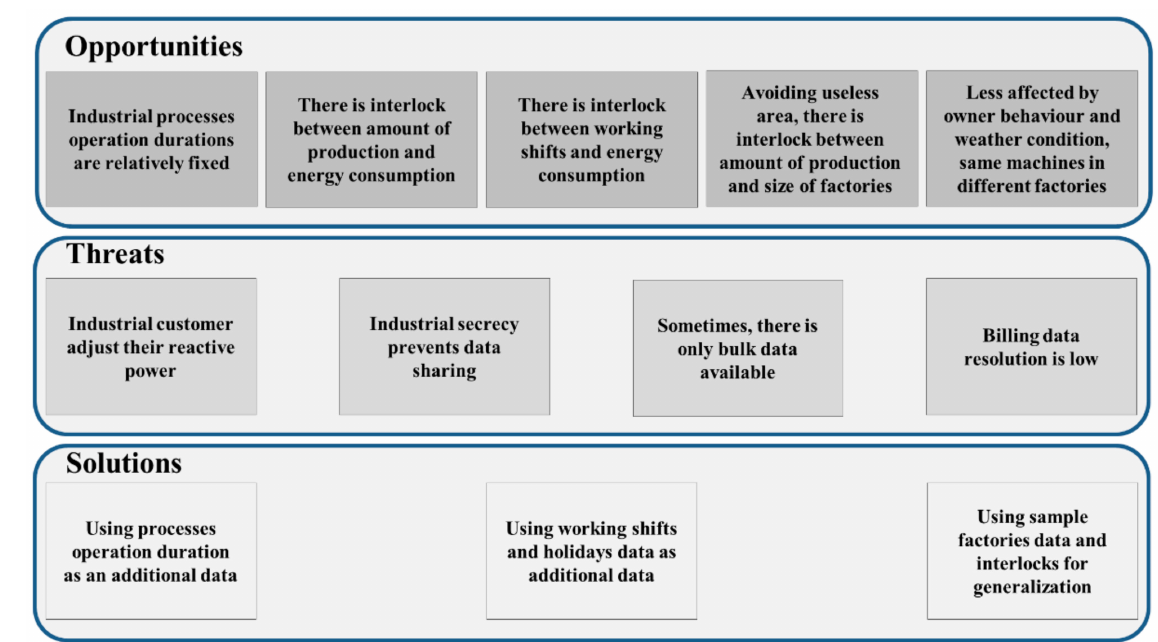
Figure 1. Industrial load features and solutions to overcome threats using